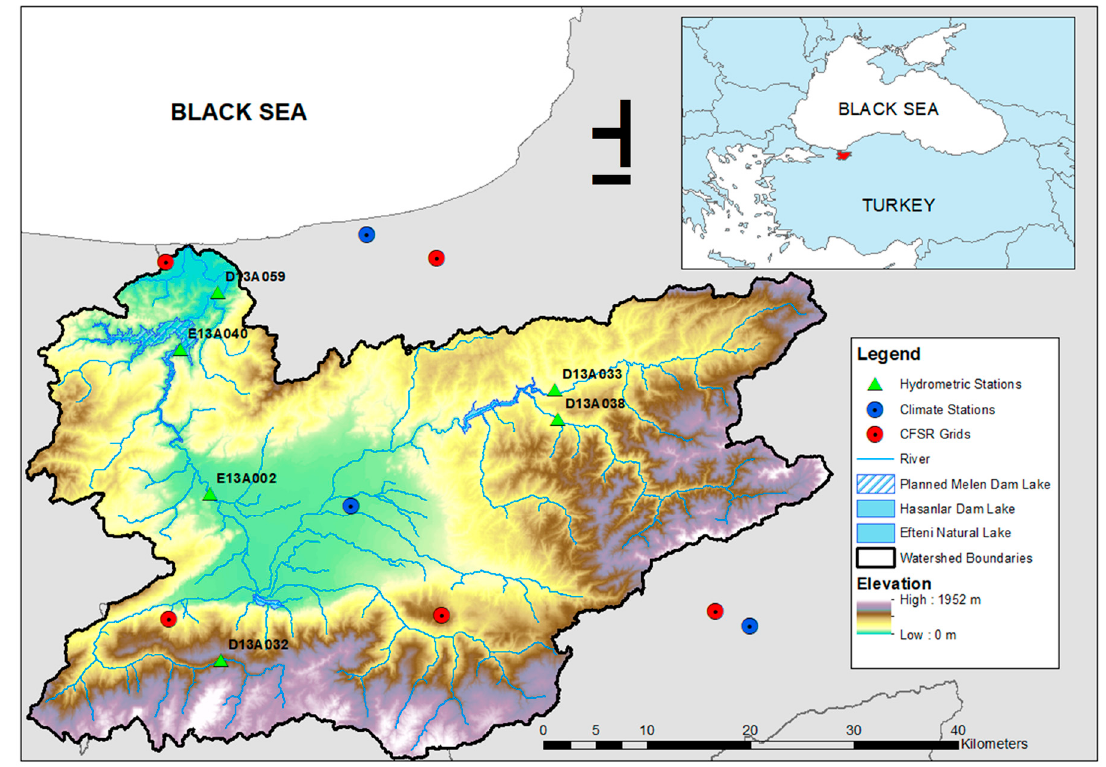
Figure 1. A map of the study area showing the river discharge stations, local and global climate stations. Background shows the topography of the Melen Watershed. Table 1. Land-use summary of the Melen